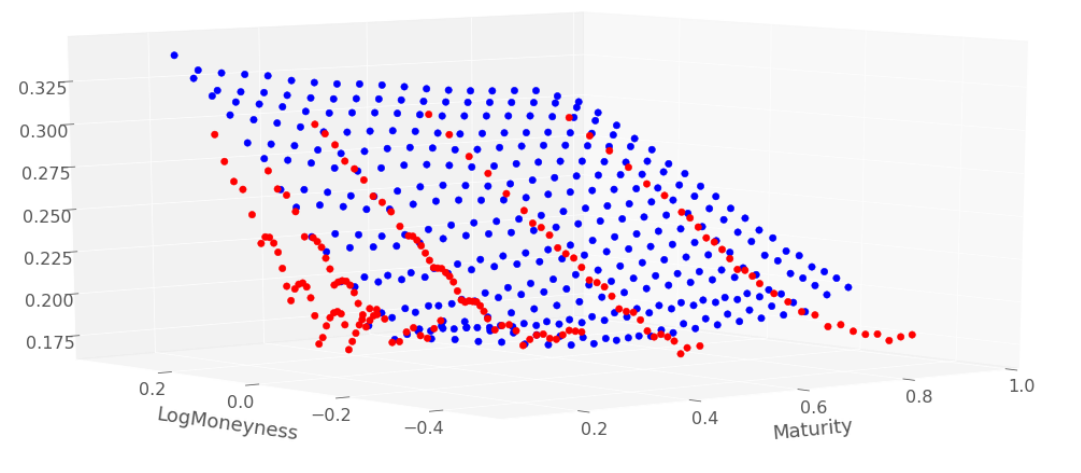
Figure 4. Same as Figure 3 in implied volatility